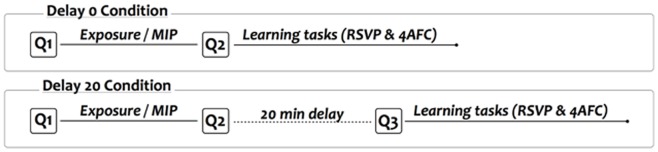
Delay.Time-course of ‘Delay 0′ and ‘Delay 20′ conditions.